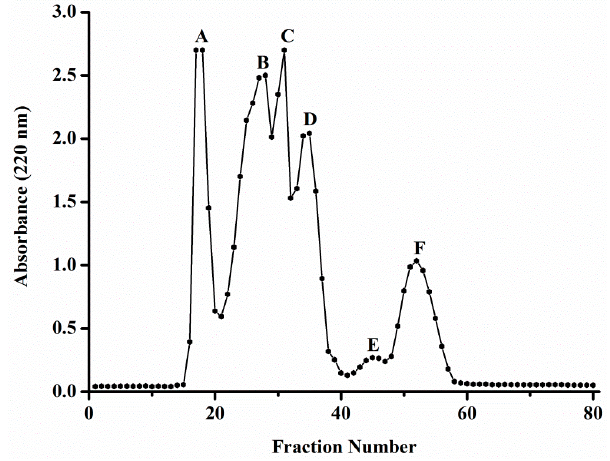
Figure 1. Elution profile of JGPH-P3 using a Sephadex G-25 column. A–F were six major parts by the Sephadex G-25 gel column.